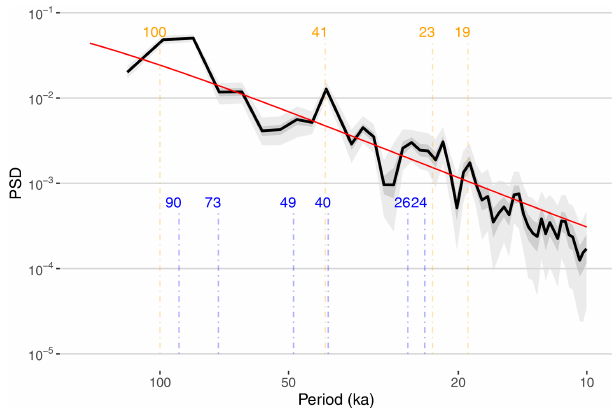
Figure 12. MTM spectrum for IODP 846. Median spectrum is shown in black, with the 50% and 95% highest-density probability ranges shown in dark and light gray, respectively. Periodicities of interest (in ka) are shown in orange, and the periodicities identified as significant by the F ratio test are shown in